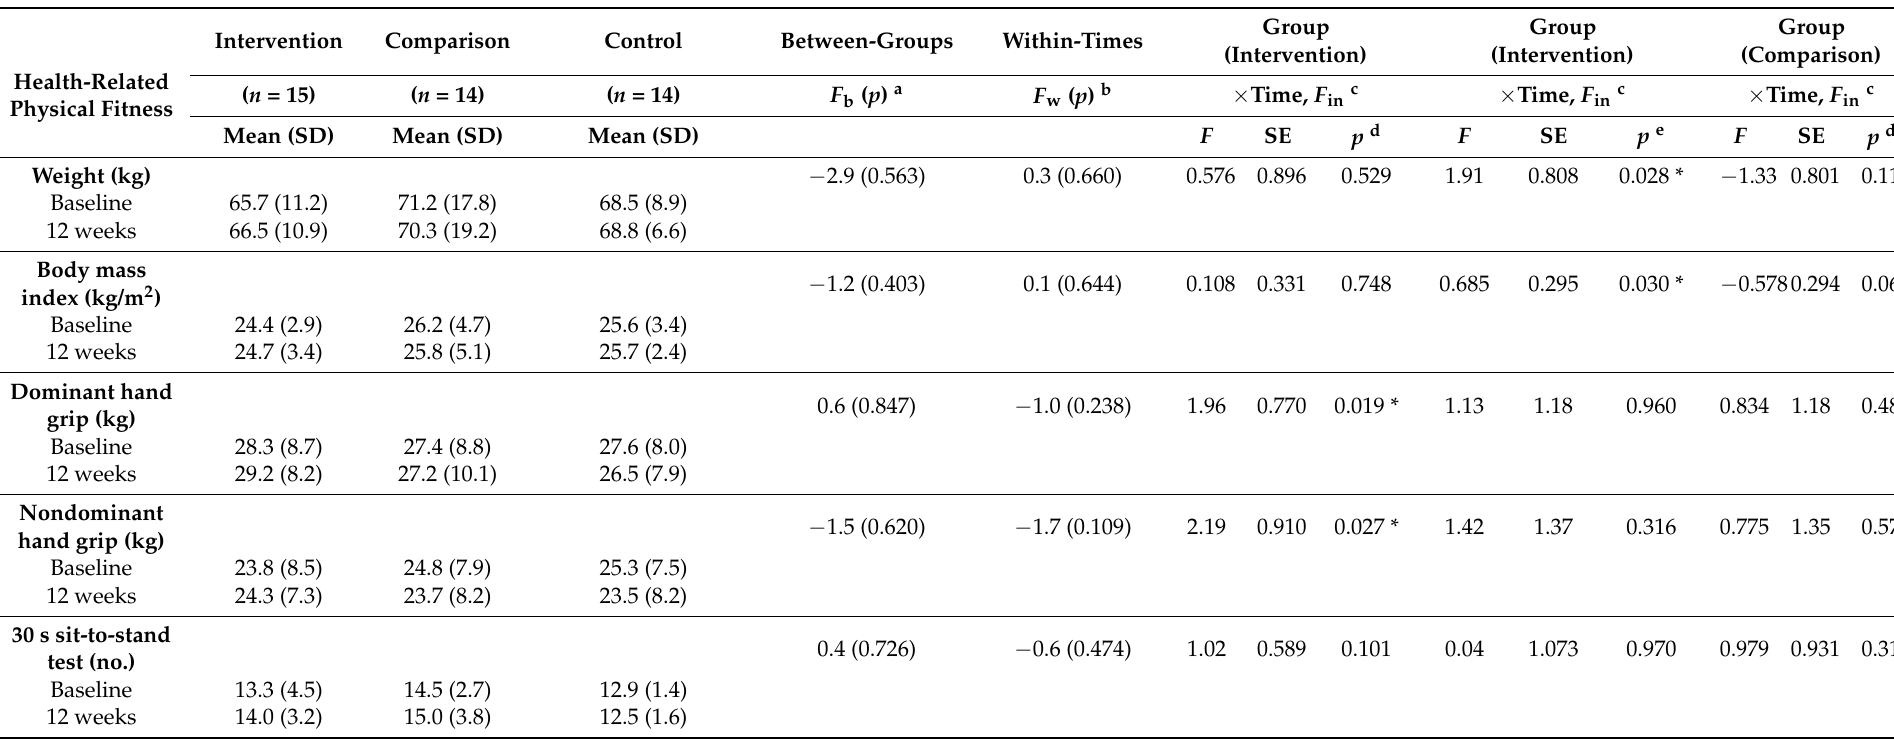
Table 4. The effectiveness of individualized aerobic exercise training combined with telephone-based motivational interviewing on body composition, muscular strength, muscular endurance, and flexibility based on mixed model